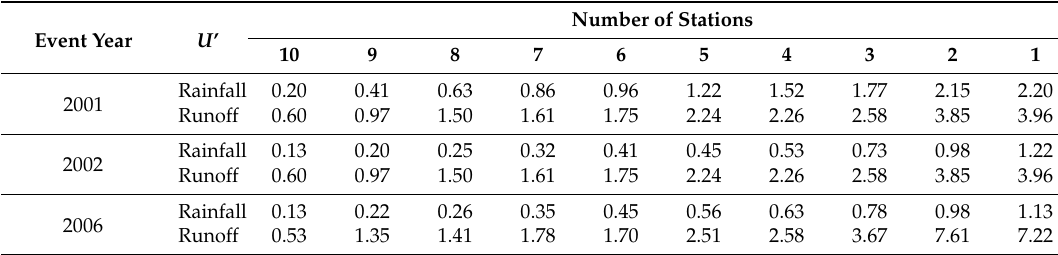
Table 5. The non-dimensional uncertainty ranges ( U ’) of rainfall and simulated runoff depth.